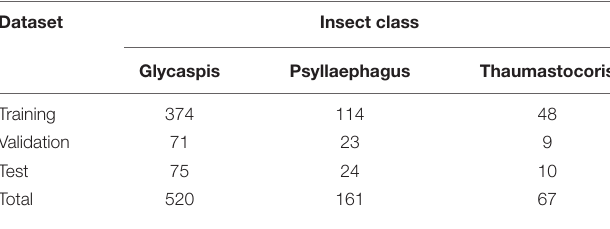
TABLE 2 | The numbers of individuals used for training, validation, and testing of the deep learning